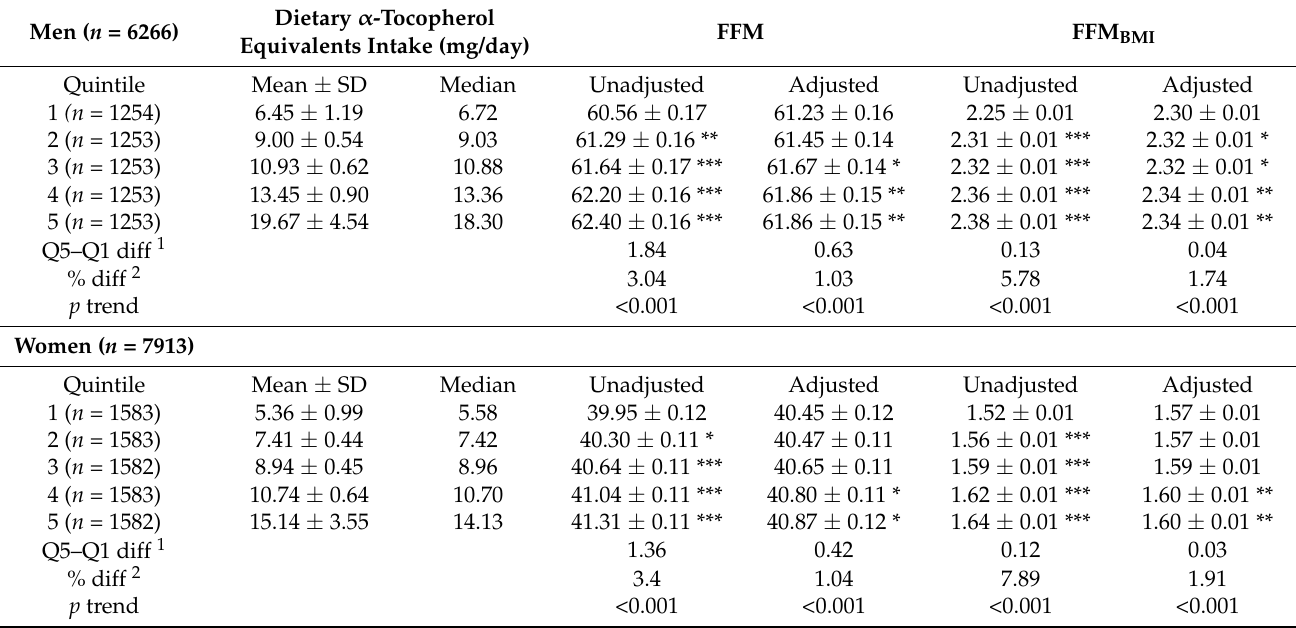
Table 3. Associations between quintiles of dietary vitamin E and skeletal muscle mass in men and women aged 42–82 years. Men ( n =